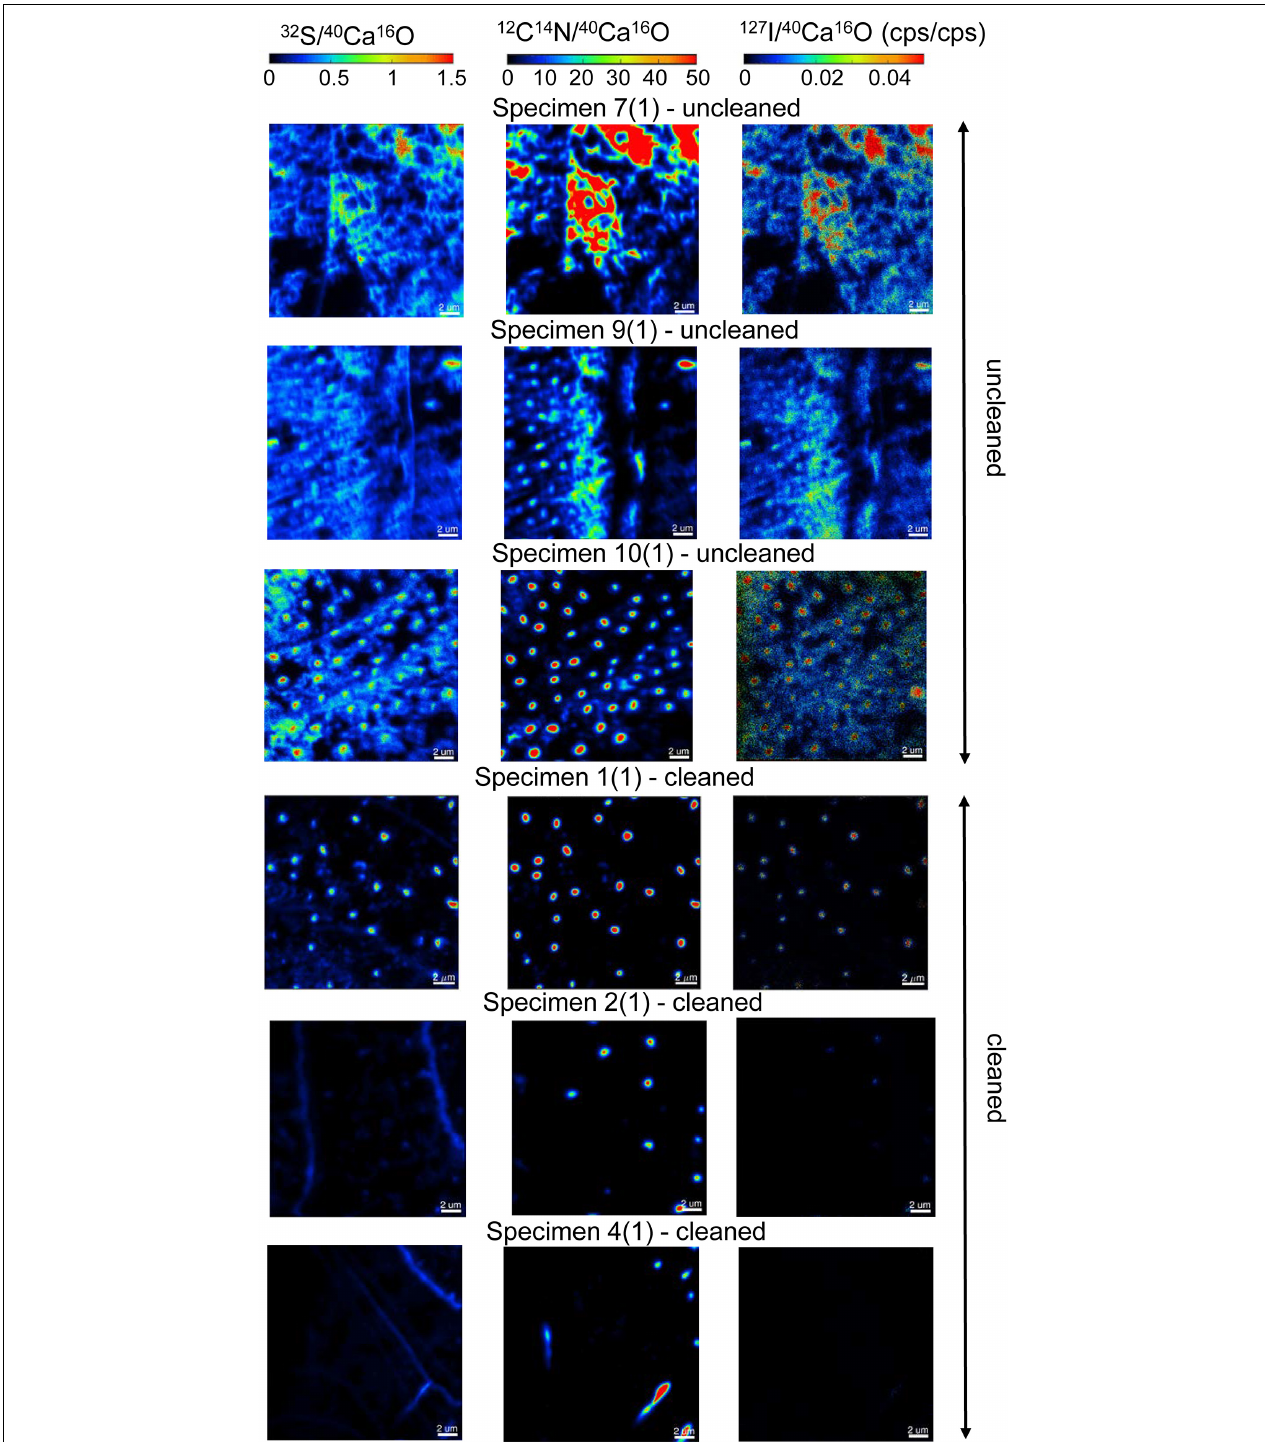
FIGURE 2 | A comparison of six NanoSIMS mappings on cross-sections of three different uncleaned U. striata specimens and three specimens that have been treated by an oxidative cleaning before embedding for the preparation of the cross-sections. Different isotope ratios are shown: 32 S − / 40 Ca 16 O − (Left) , 12 C 14 N − / 40 Ca 16 O − (Middle) , and 127 I − / 40 Ca 16 O − (Right) . The individual ion ratios use the same scaling on all element-maps for a better direct comparison of the analyses. Note the distinct differences of the element distributions between the cleaned and uncleaned specimens. The oxidative cleaning procedure affected all elements (S, N, and I) by removing parts of the organic matrix from within the foraminiferal calcite. Note that the mappings shown here were located within the foraminiferal calcite, showing no signal from the